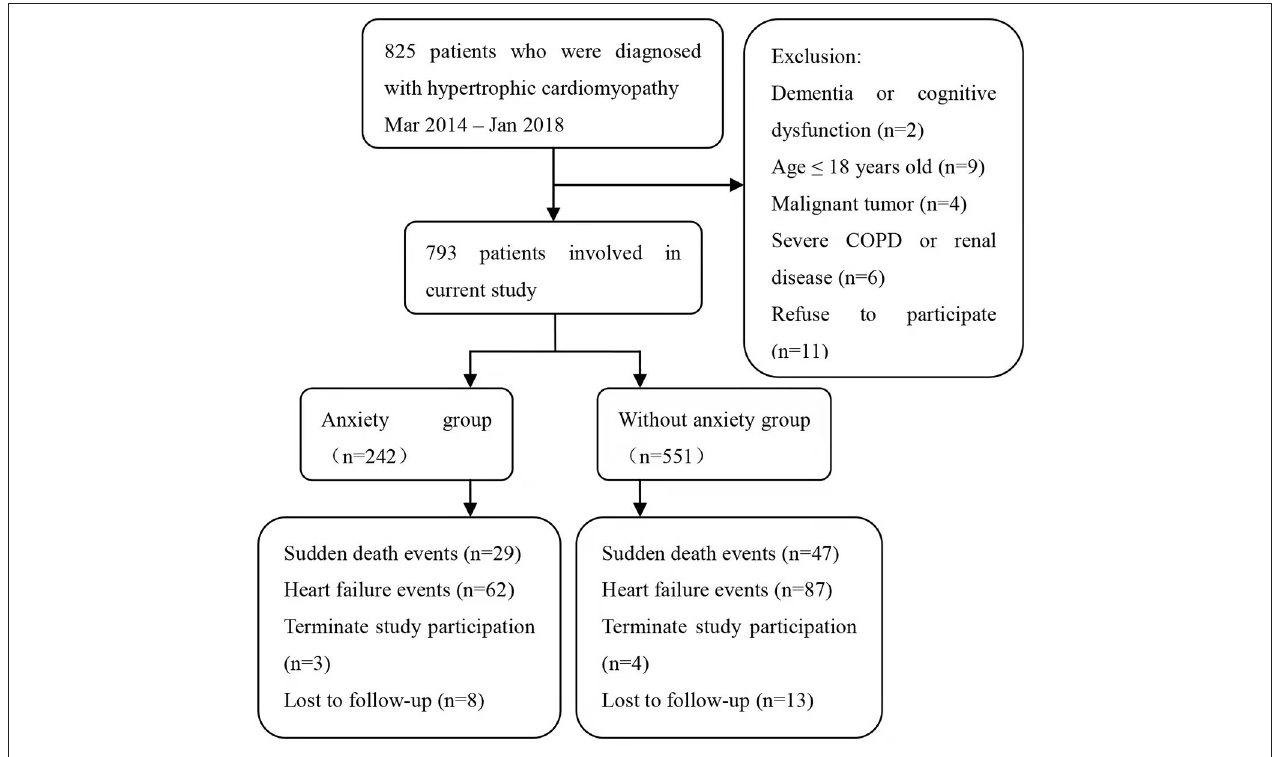
FIGURE 1 | Flowchart of the screening process and dropouts of the present